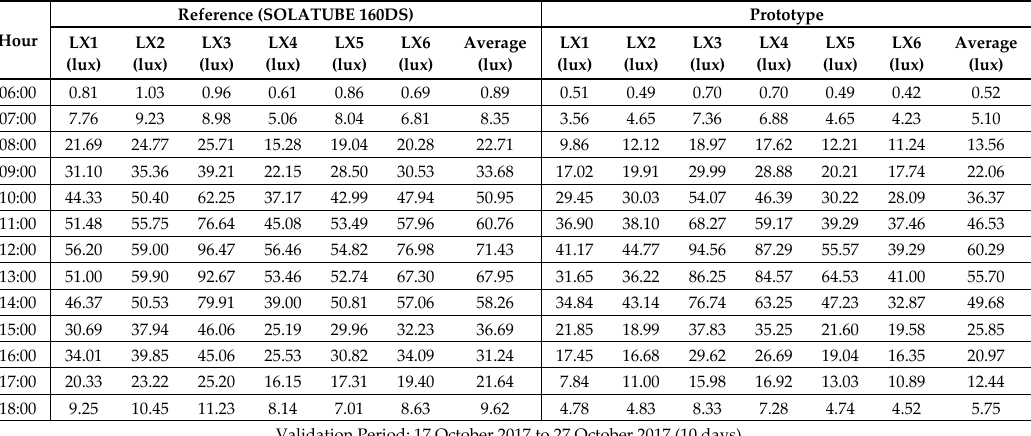
Table 4. Table of the average hour of the validation days (Reference vs. Prototype).